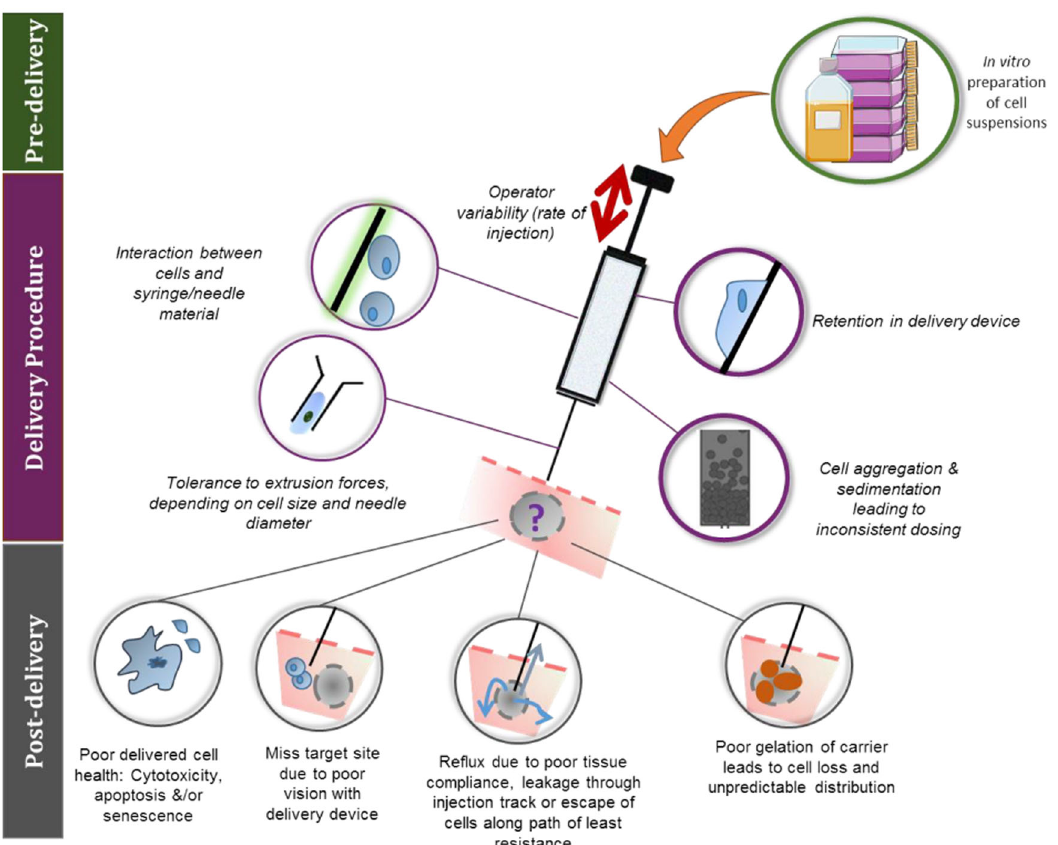
Fig. 1 Common problems with injectable cell delivery and possible cell fates. Three stages make up a typical cell-therapy protocol: in vitro preparation (pre-delivery), injection (delivery) and subsequent retention (post-delivery) of injected